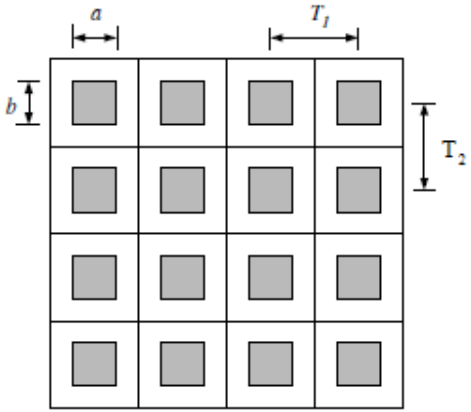
Figure 1. Critical dimensions of the uniform detector array